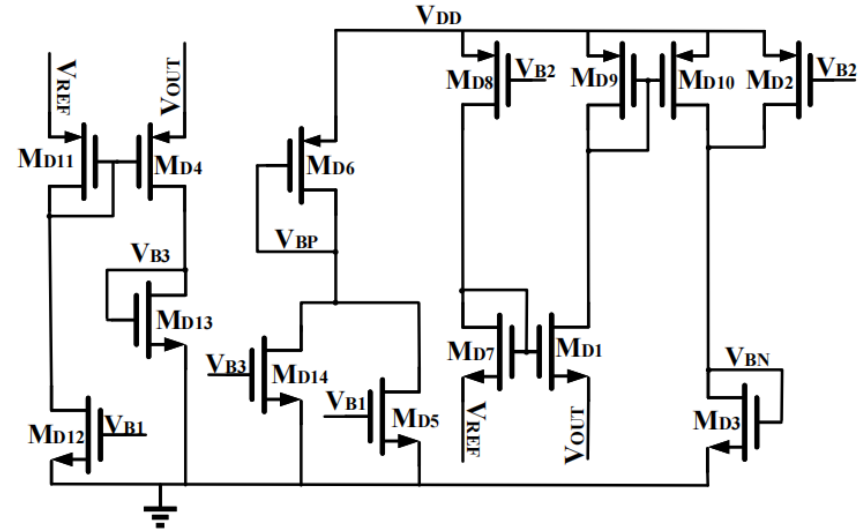
Figure 5. Dynamic bias circuit.